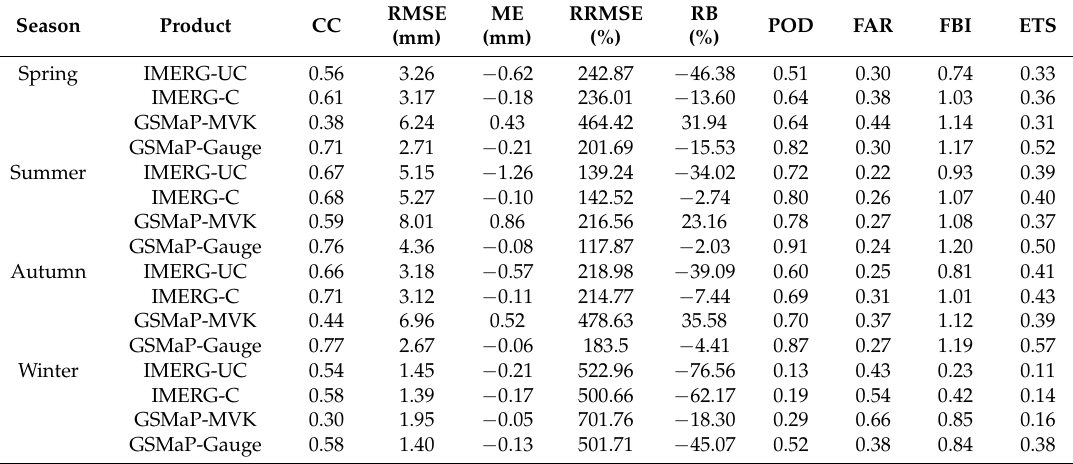
Figure 6. ( a ) Average monthly precipitation time series and monthly variations of statistical indices: ( b ) CC, ( c ) RMSE, and ( d ) RB. Table 3. Seasonal statistics of four satellite precipitation estimates (IMERG-UC, IMERG-C, GSMaP-MVK, and GSMaP-Gauge) against ground observations over the Tibetan Plateau (TP) during the study period of April 2014–March 2017.